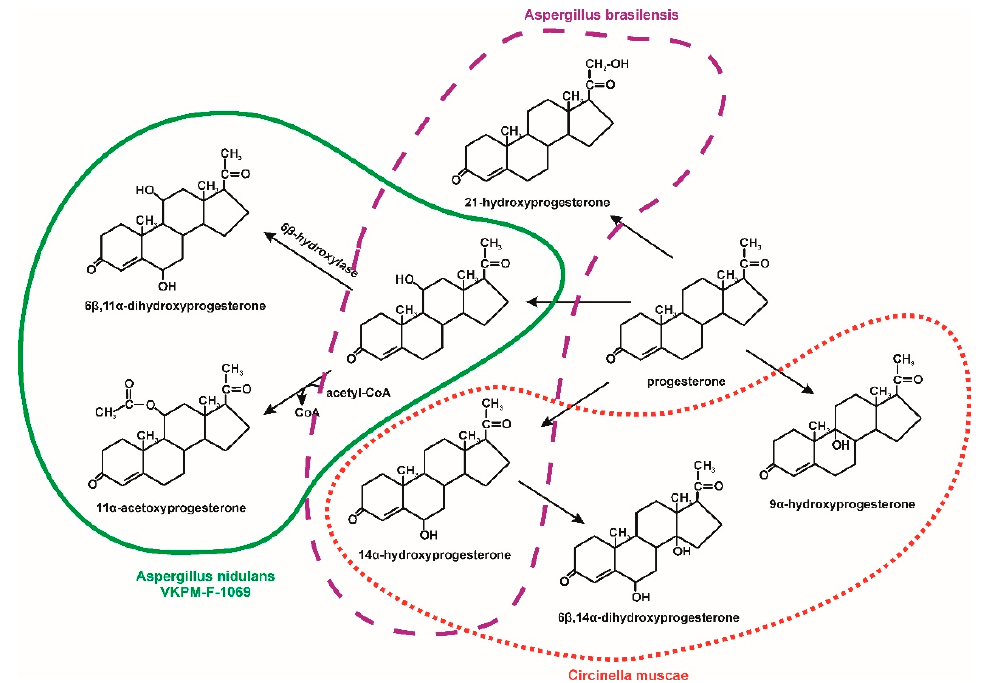
Figure 7. Progesterone biotransformation by fungi [42,45,46]. Molecules 2020 , 25 , x FOR PEER REVIEW